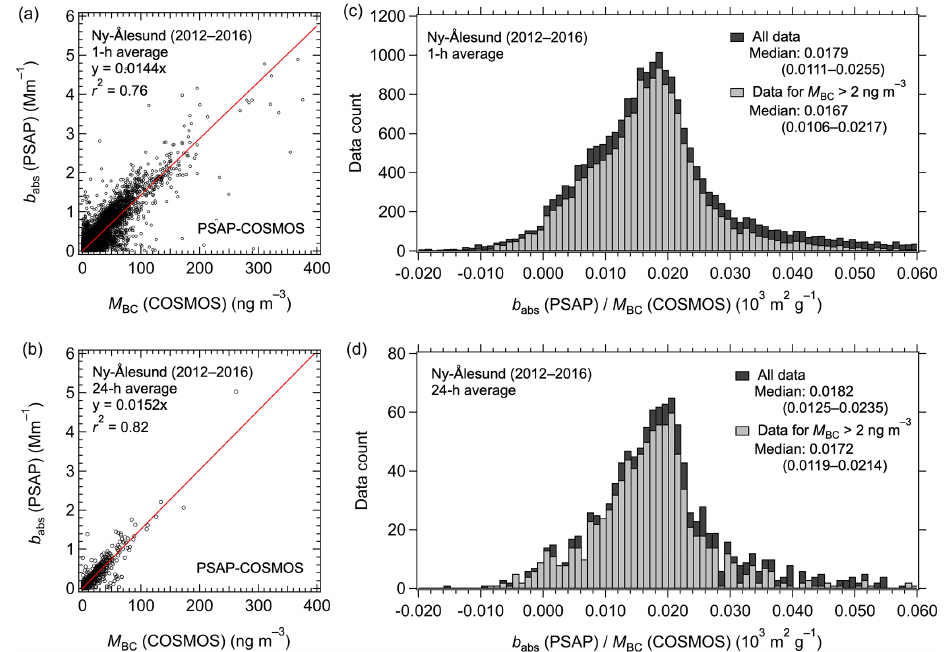
Figure 6. Correlations of M BC (COSMOS) and b abs (PSAP; λ = 550nm) from April 2012 to September 2016 at Ny-Ålesund for (a) 1h averaged and (b) 24h averaged data. The solid red lines are the least-squares regressions forced through the origin. (c, d) Corresponding histograms of b abs (PSAP) /M BC (COSMOS) ratios for all data and data with M BC (COSMOS) > 2ngm − 3